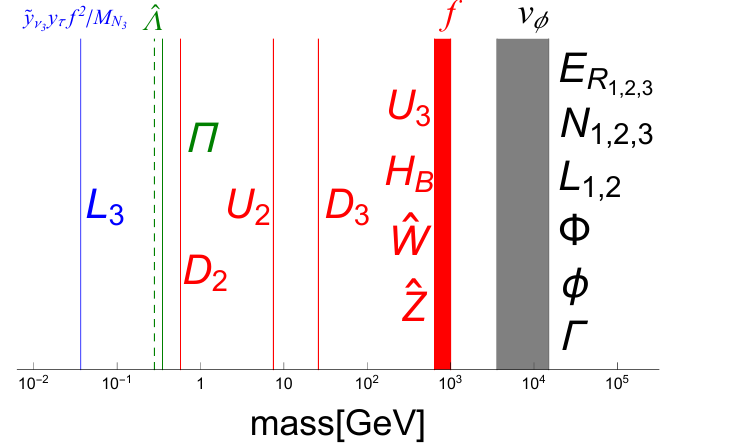
Figure 1 . A schematic of the spectrum of the theory with the field content in table 3, where ˜ y ν = y ν /κ 3 3